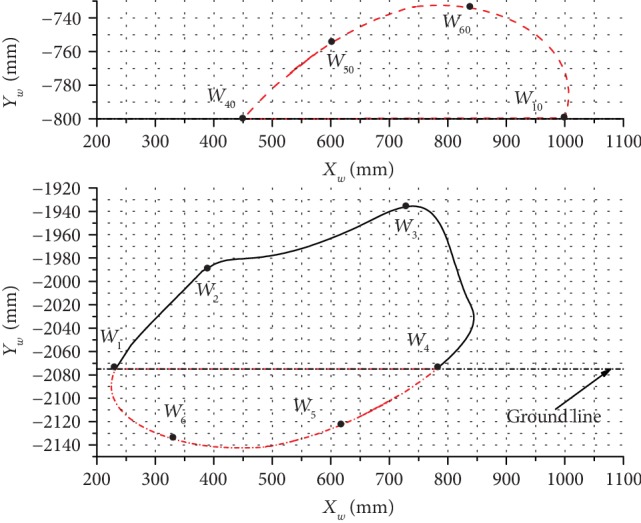
The trajectories of the leg end-point (bottom) and the body (top) at α1 = 14.5°.